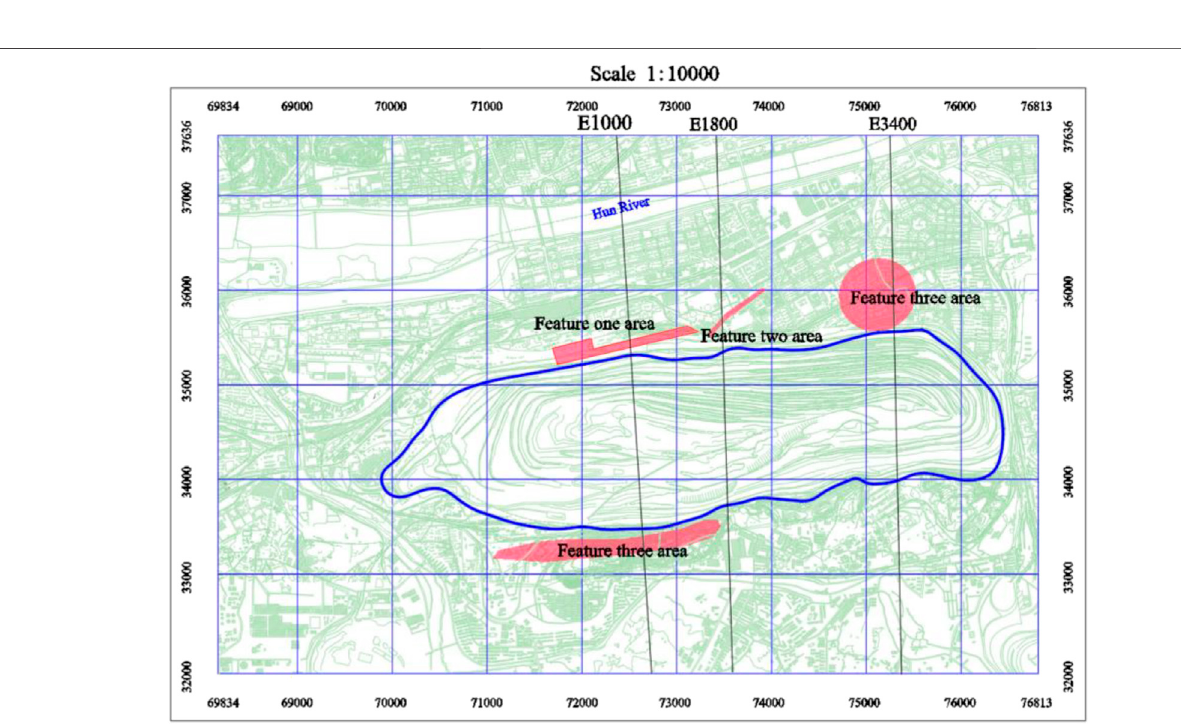
FIGURE 2 | Deformation zone map of the west open-pit in fl uence